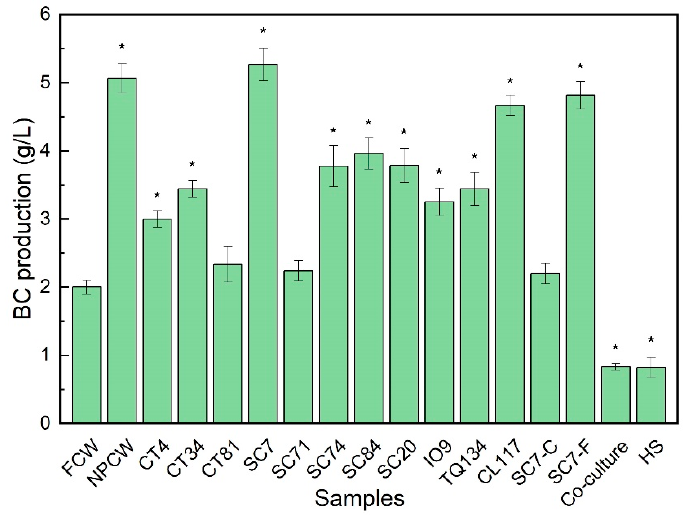
Figure 1. Production of BC in different coconut water media. FCW: fresh coconut water medium; NPCW: natural pre-fermented coconut water medium; CT4, CT34, CT81: the media of coconut water pre-fermented by Candida tropicalis CT4, CT34, and CT81, respectively; SC7, SC71, SC74, SC84, and SC20: the media of coconut water pre-fermented by Saccharomyces cerevisiae SC7, SC71, SC74, SC84, and SC20, respectively; IO9: the medium of coconut water pre-fermented by Issatchenkia orientalis IO9; TQ134: the medium of coconut water pre-fermented by Torulaspora quercuum TQ134; CL117: the medium of coconut water pre-fermented by Clavispora lusitaniae CL117; SC7-C: the medium of fresh coconut water containing S. cerevisiae SC7 cells; SC7-F: the medium of coconut water pre-fermented by S. cerevisiae SC7 without cells; Co-culture represents the co-culture of K. nataicola Q2 and S. cerevisiae SC7 at a ratio of 1:1 ( v / v ) in the FCW medium; HS: HS medium. Significant differences of the samples to the control group FCW were confirmed at * p < 0.05 (n = 3).